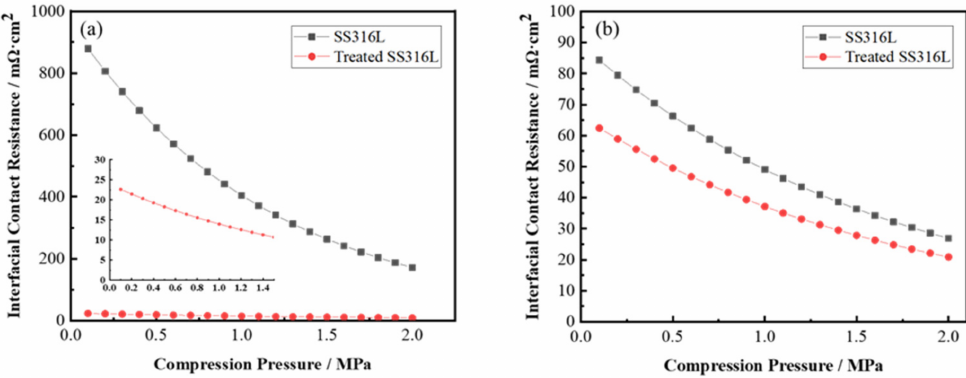
Figure 2. Interfacial contact resistance (ICR) of original and treated SS316L. ( a ) before potentiody- namic tests and ( b ) after potentiodynamic